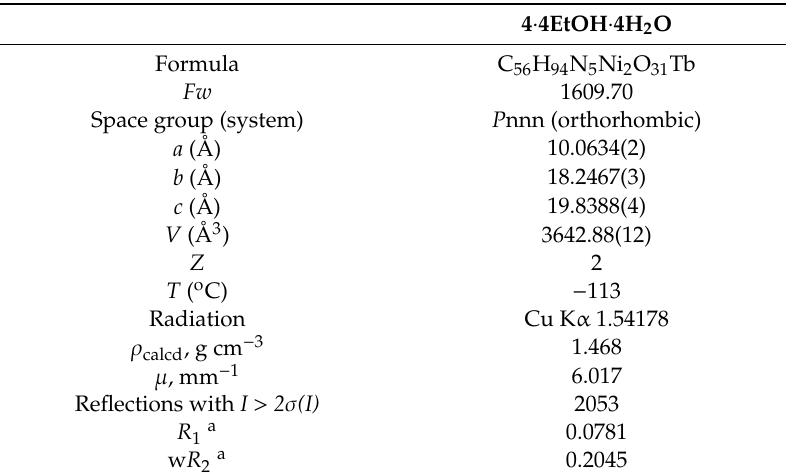
Table 3. Crystallographic data for 4 · 4EtOH · 4H 2